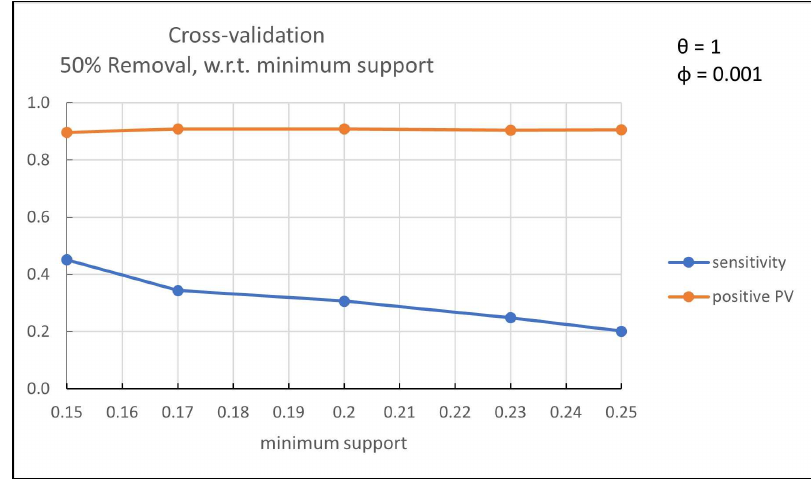
Figure 4. Cross-validation results (50% removal, minimum support = 0.15).